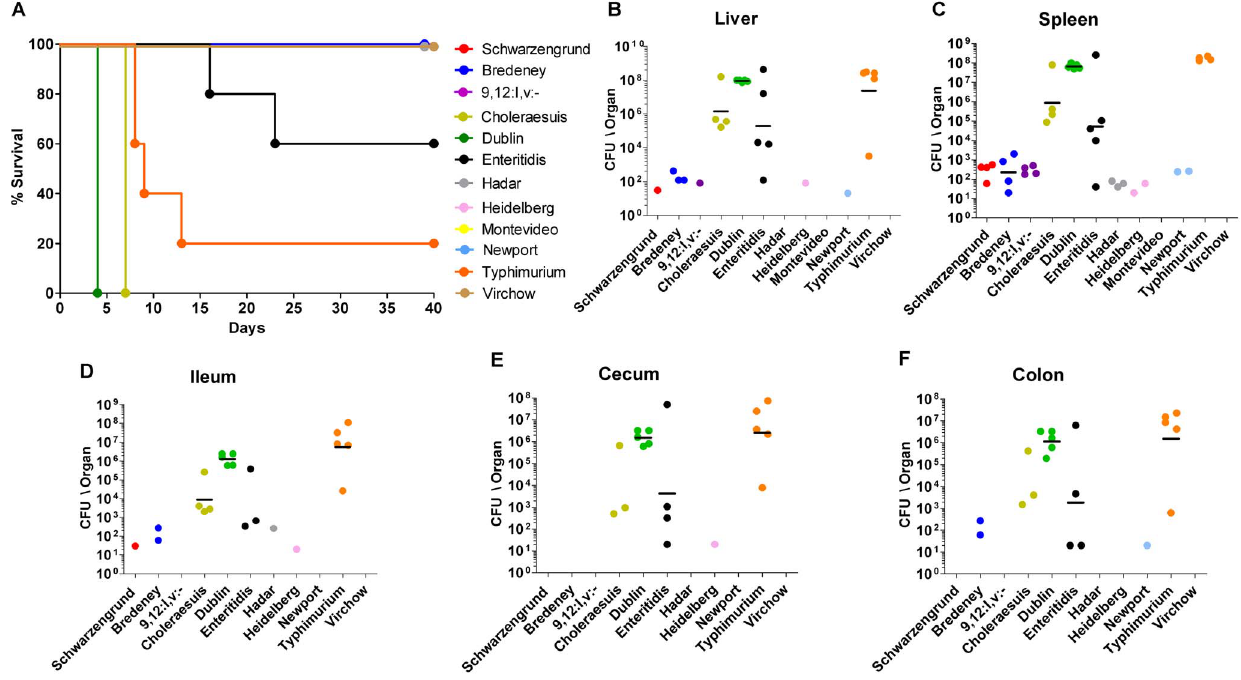
Figure 4. Pathogenicity of iNTS strains in mice. Twelve groups of 4–5 female C3H\HeN mice were challenged i.p. with , 5 6 10 3 CFU of bacteremic strains from serovars Schwarzengrund (isolate number 124983), 9,12:l,v:- (94293), Bredeney (96115), Choleraesuis (90958), Dublin (74007), Enteritidis (122205), Hadar (121851), Heidelberg (78646), Montevideo (111072), Newport (91532), Typhimurium (103259), and Virchow (103033). Survival of the mice during 40 days post-infection is shown (A). At end-points (as shown in A), harvested organs were homogenized and serial dilutions were plated onto XLD-agar plates for CFU count. Bacterial load in each mouse is represented as CFU/organ by individual dots in the liver (B), spleen (C), ileum (D), cecum (E), and colon (F). Geometric mean for each serovar in the different sites is shown by a horizontal